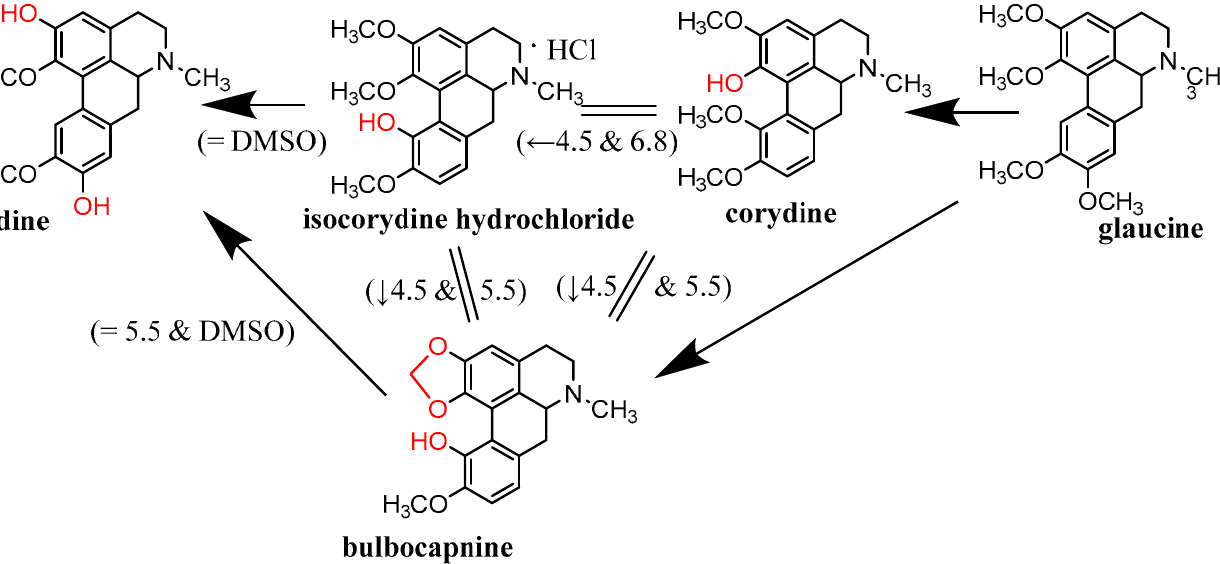
Figure 6. Graphical depiction of cupric-reduction potencies of tested aporphine alkaloids. Arrows point to stronger reduction compounds. Exceptions to the general scheme are shown in parentheses, including the conditions.